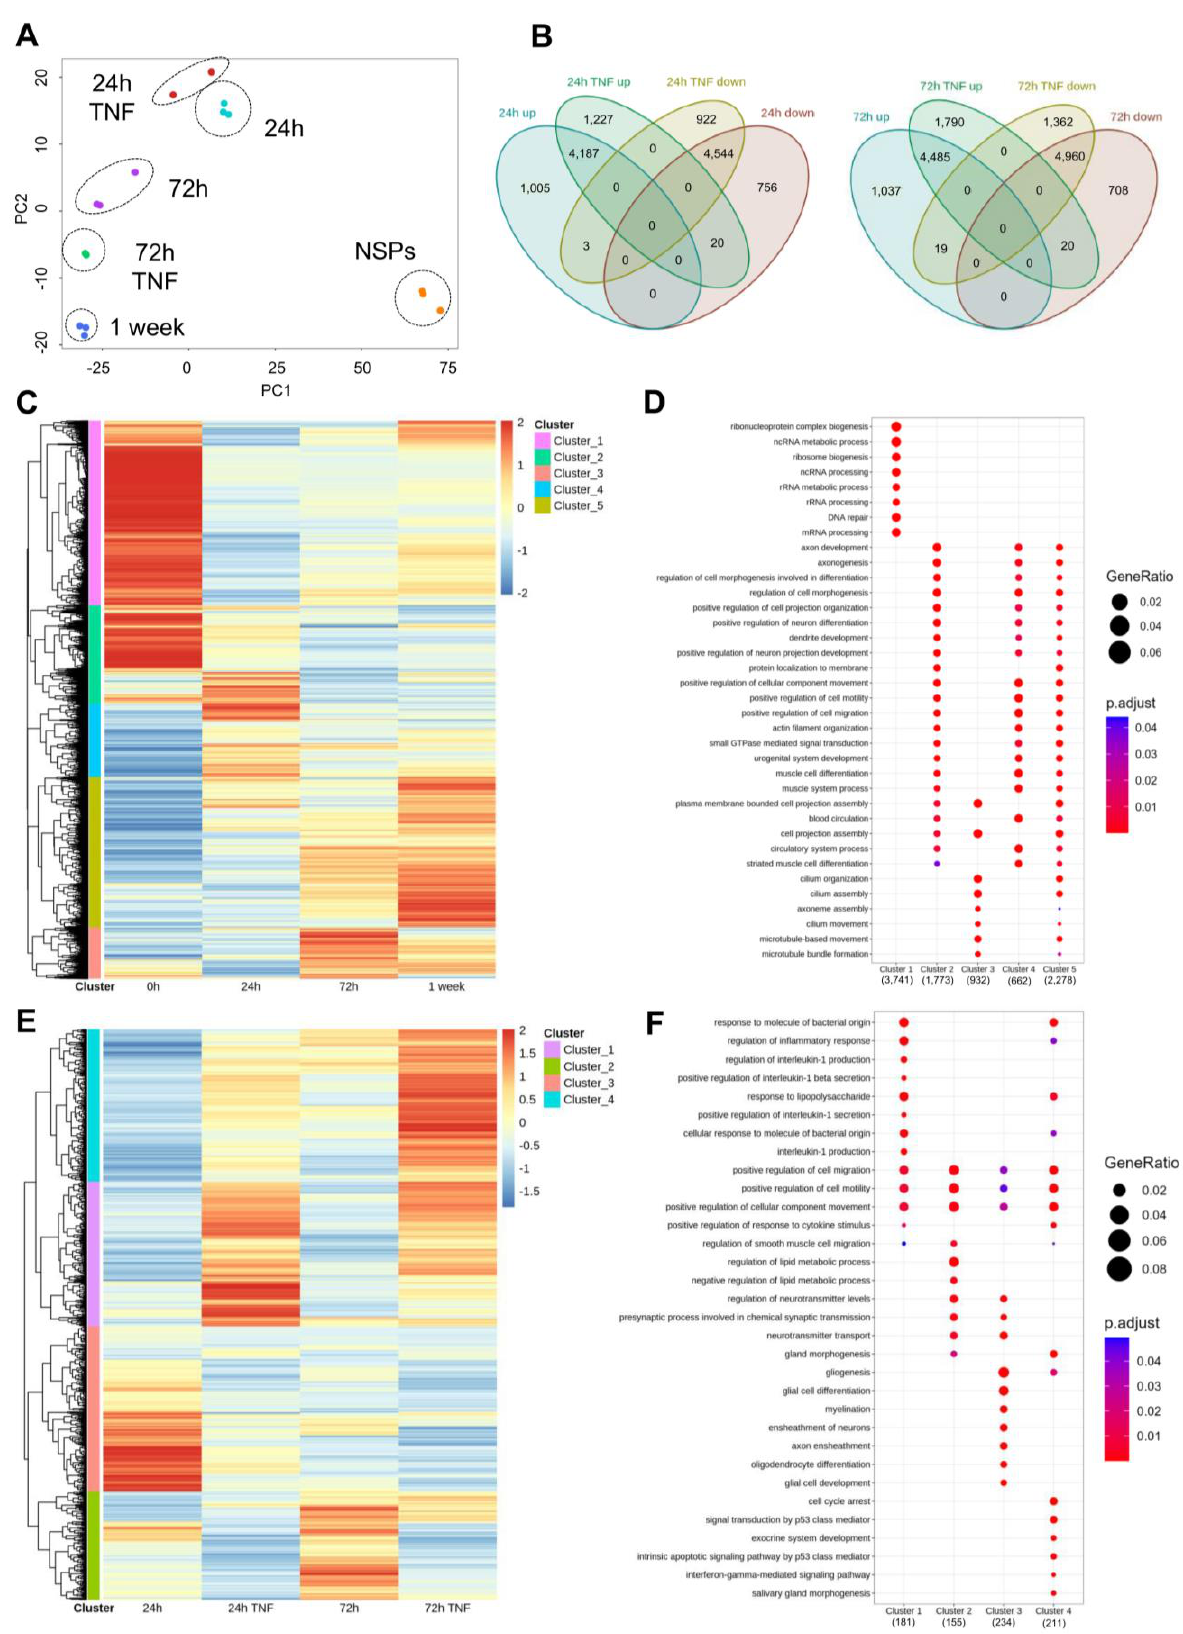
Figure 3 . Transcriptomic signature of differentiating astrocytes under normal and inflammatory Figure 3. Transcriptomic signature of differentiating astrocytes under normal and conditions. ( A ) Representation of first two principal components (PC) analysis of the top 1000 most